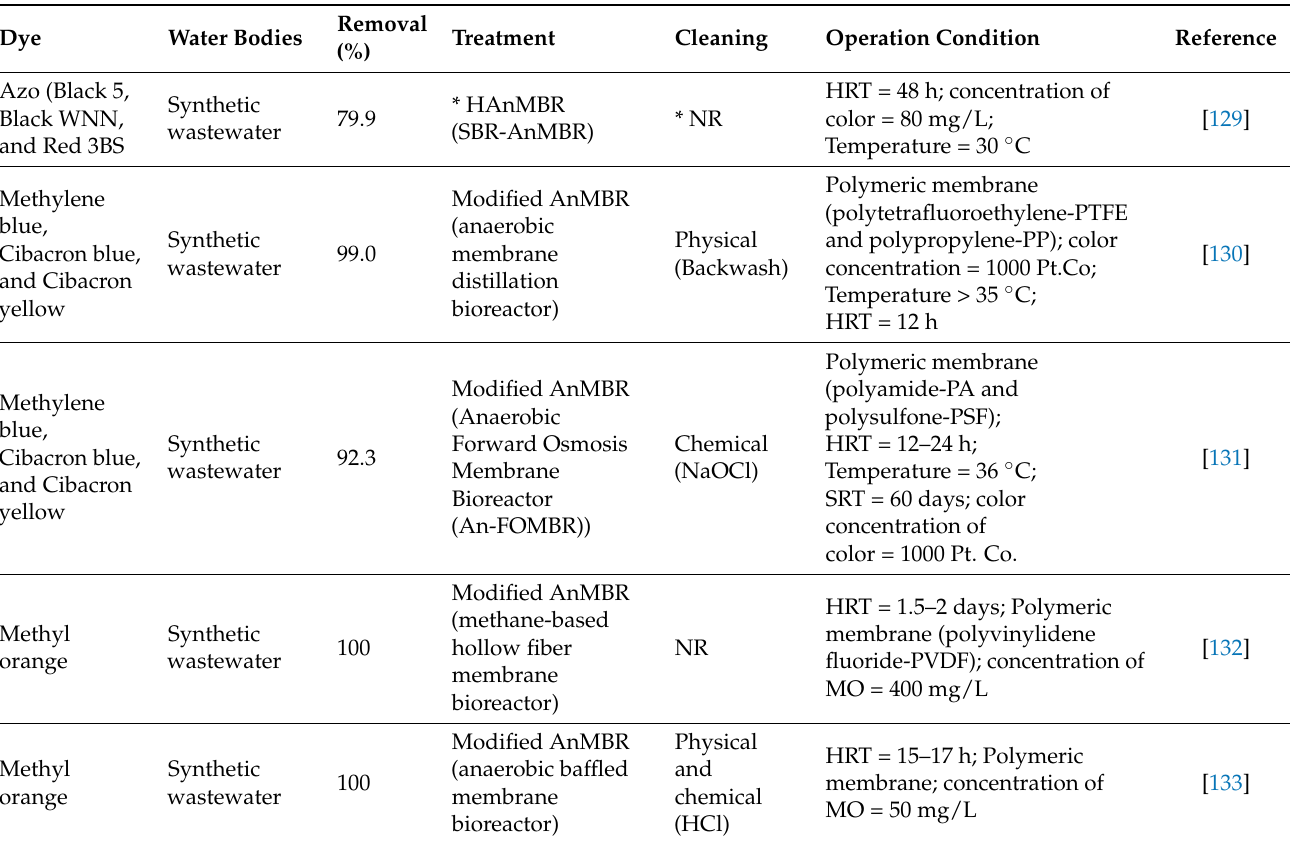
Table 3. The performance of AnMBR in the removal of